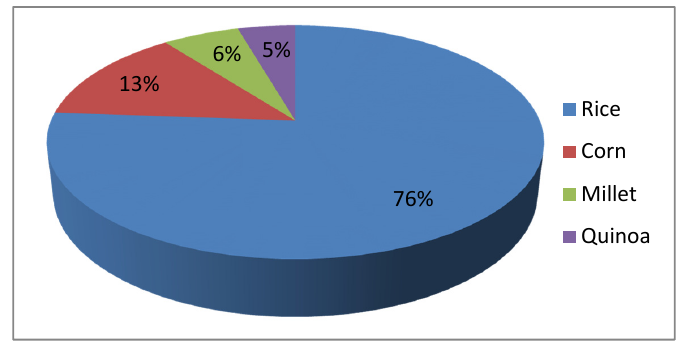
Figure 3. Raw cereal consumption of CD patients.